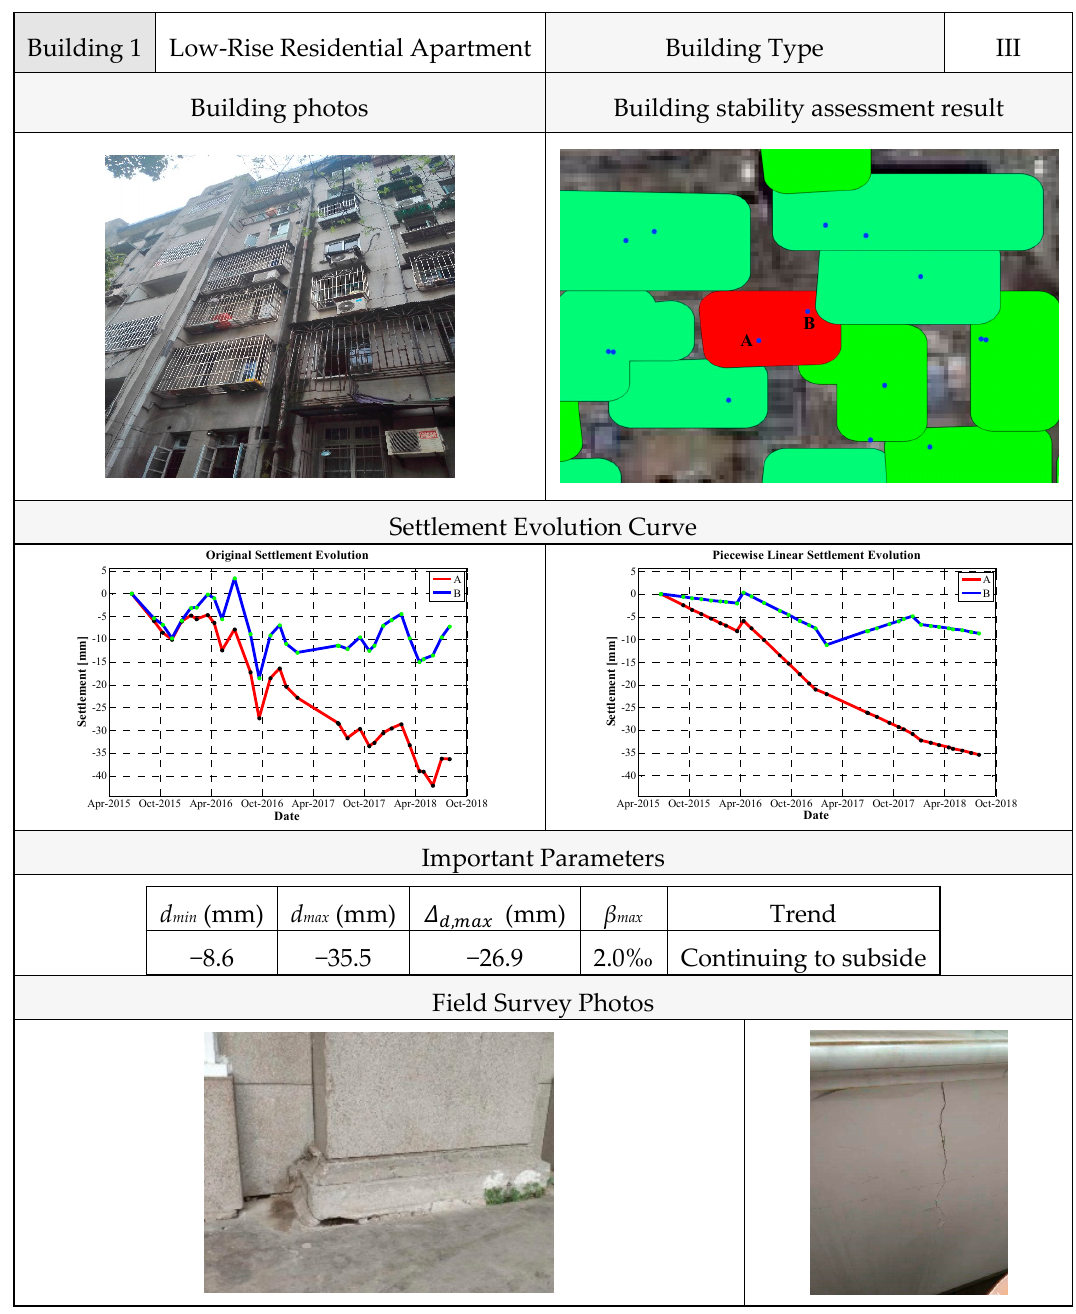
Figure 17. Example of analysis results: Building 1.